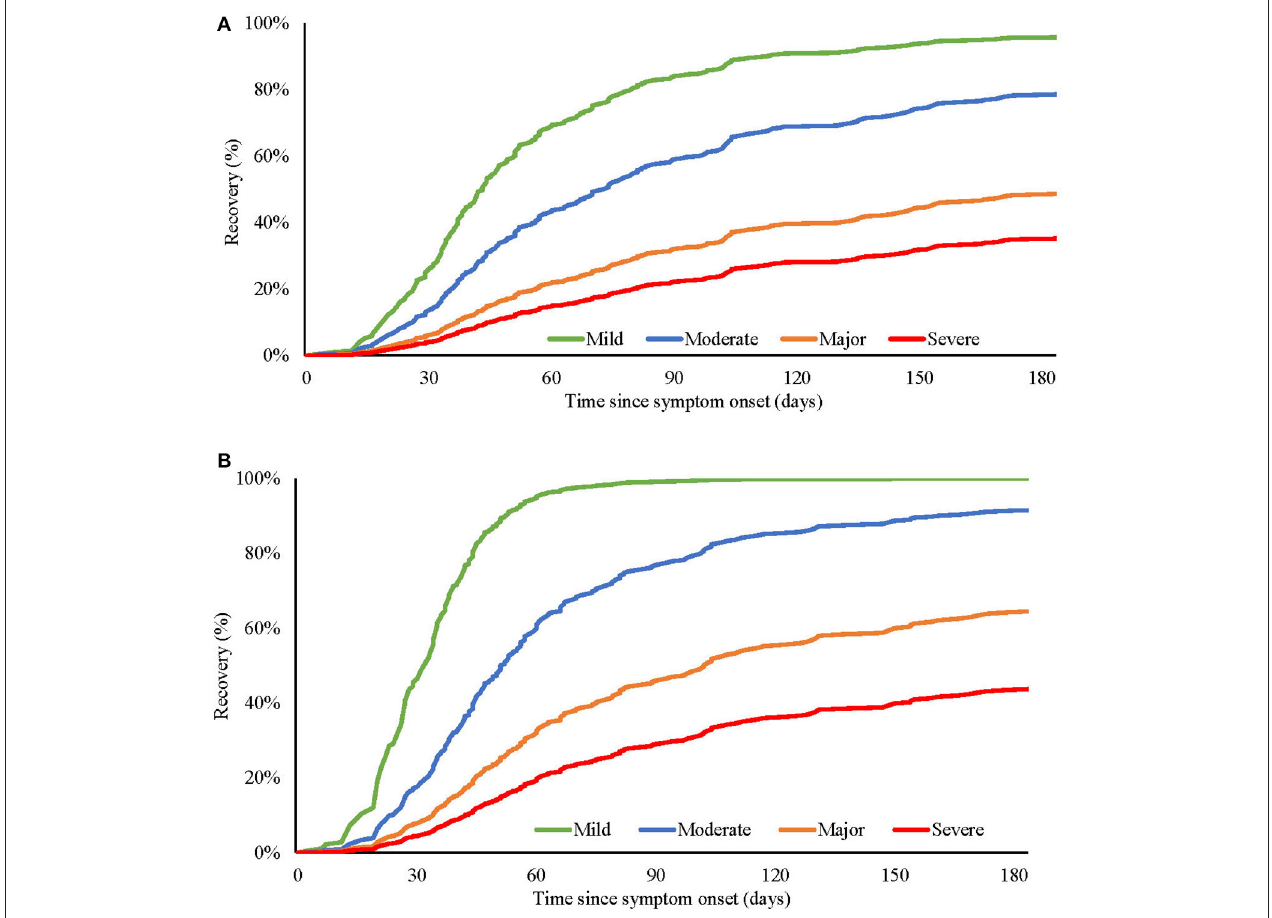
FIGURE 1 | Predicted recovery of (A) overall illness severity and (B) mood disturbance severity, at different baseline levels (mild, moderate, major, and severe) of overall illness (A) , or mood disturbance (B)